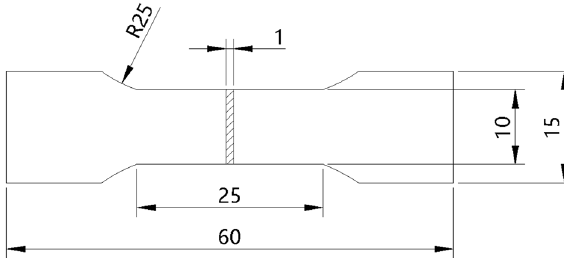
Figure 3. Schematic diagram of tensile specimen (mm).